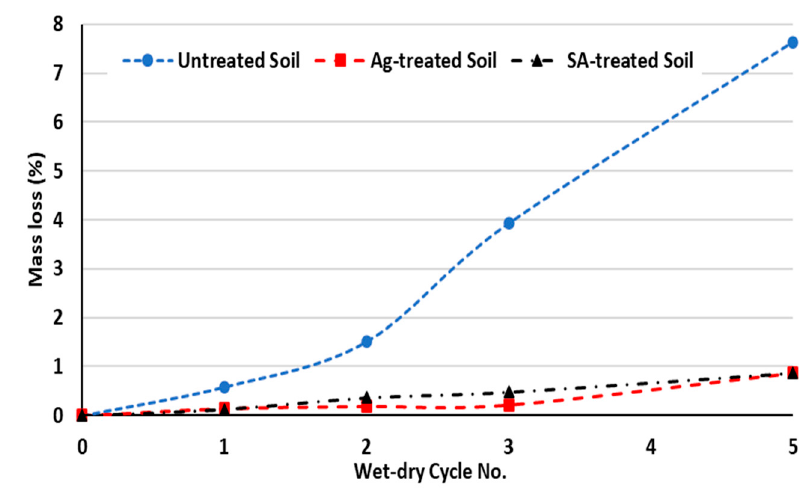
Figure 7. Mass loss of soil specimens with repetitive wet–dry cycles.